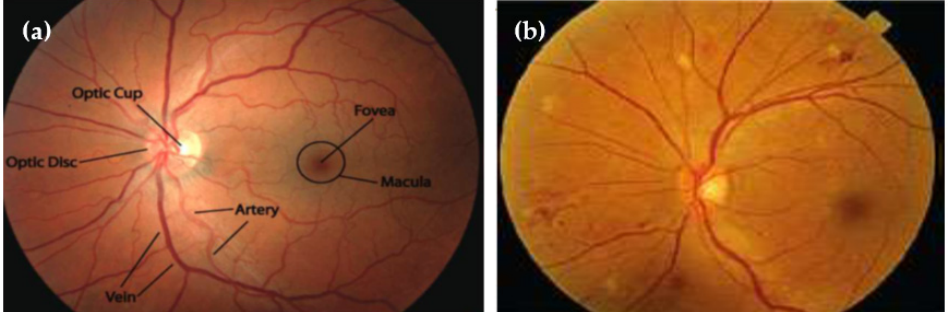
Figure 2. A visual diagram of ( a ) normal and ( b ) hypertensive retinopathy via diagnosis by retinal fundus images.